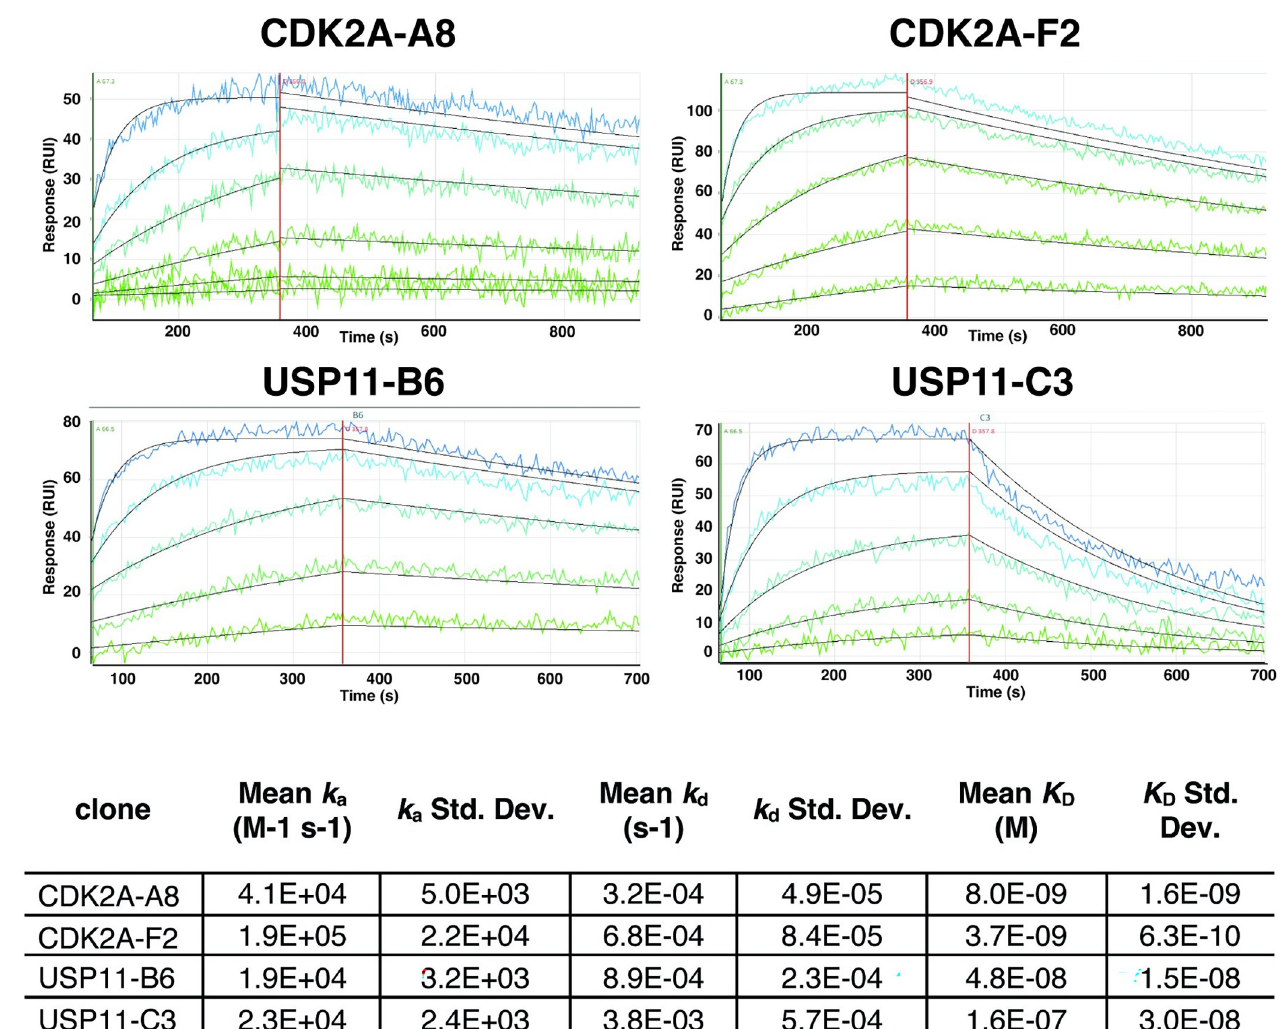
Fig 7. SPR based affinity measurement for scTGPs. The sensograms for four scTGPs (CDK2A-A8, CDK2A F2, USP11 B6 and USP11 C3) for their specific antigen is shown along with the association rate constant k a and dissociation rate constant K D as well as the affinity constant K D ( k d / k a ).